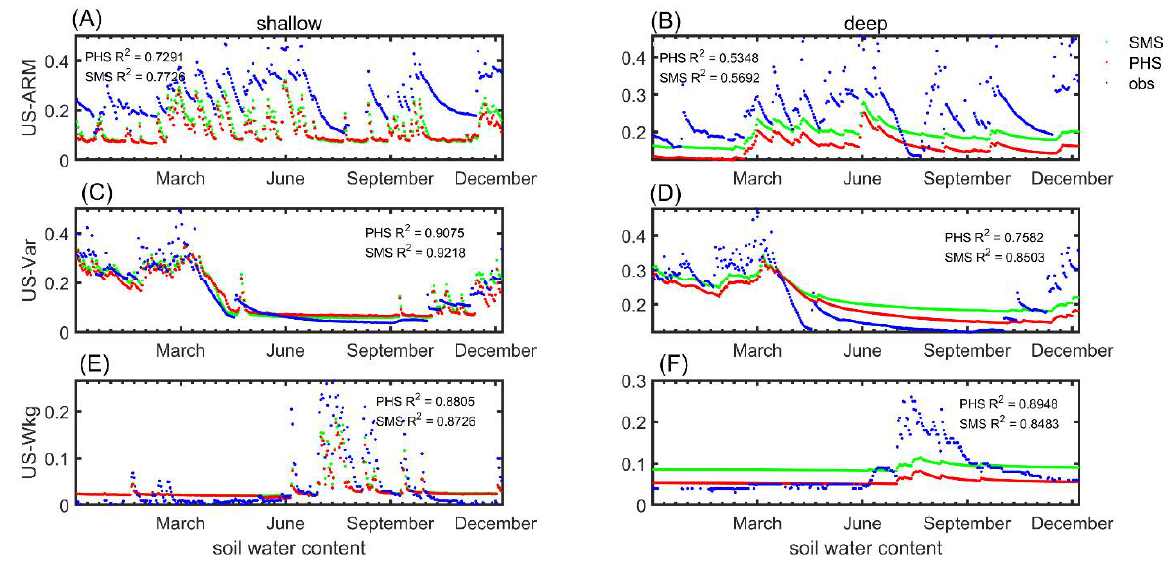
Figure 8. Comparison of soil water content (m 3 /m 3 ) between model and observation. ( A ) the comparison of soil water content at US-ARM in 2007 for shallow soil layer; ( B ) the comparison of soil water content at US-ARM in 2007 for deep soil layer; ( C ) the comparison of soil water content at US-Var in 2006 for shallow soil layer; ( D ) the comparison of soil water content at US-Var in 2006 for deep soil layer; ( E ) the comparison of soil water content at US-Wkg in 2006 for shallow soil layer; ( F ) the comparison of soil water content at US-Wkg in 2006 for deep soil layer.